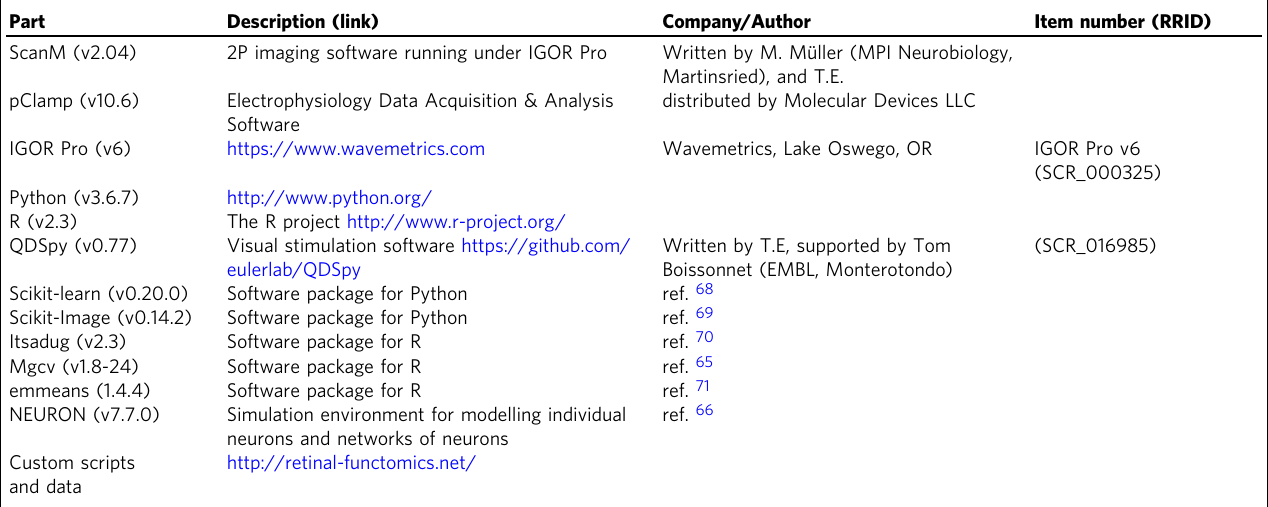
Table 2 Software used and repositories for custom scripts and